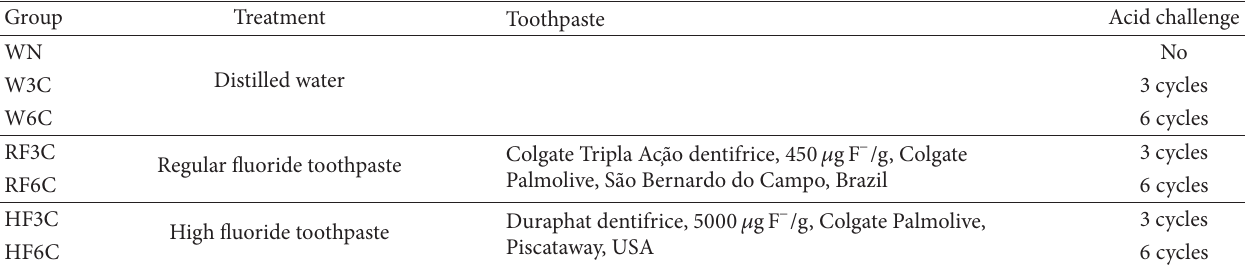
Table 1: The groups were divided according to treatment and acid